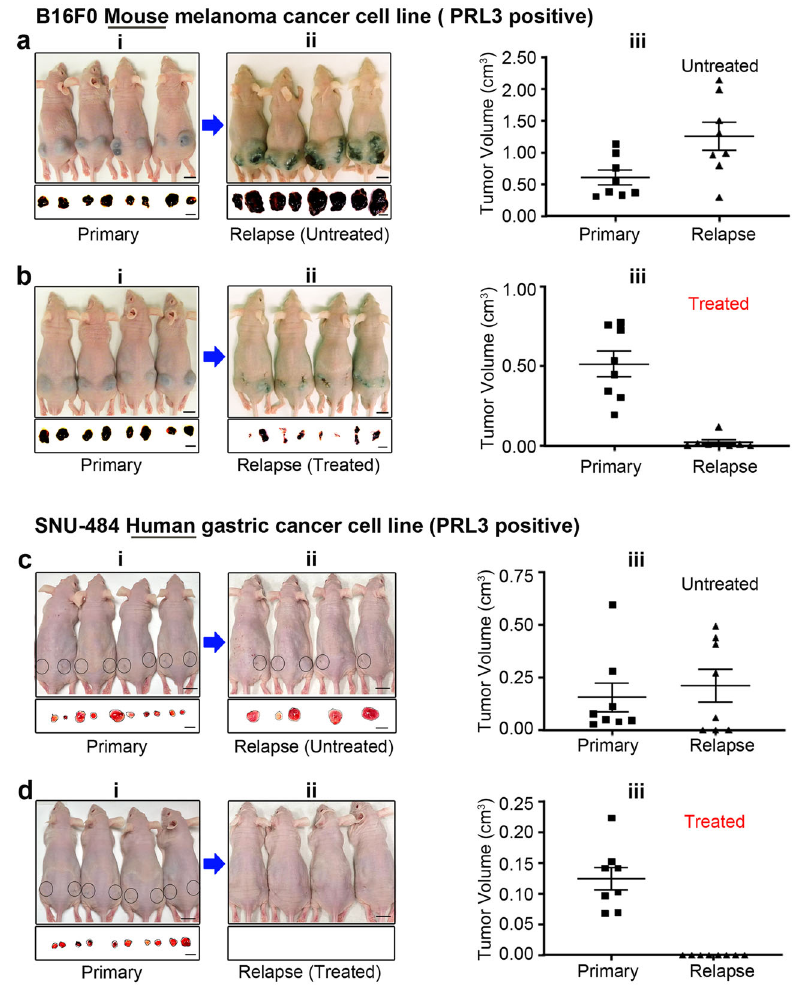
Fig. 4 PRL3-zumab, as an ‘ Adjuvant Immunotherapy ’ after tumor removal, prevent tumor relapse. a , b Mice with xenograft tumors formed by B16F0 (PRL3 positive) cells: 2 weeks after inoculation ( a – i , b – i upper panels) and removed primary tumors in black ( a – i , b – i , lower panels). Mice with relapse tumors formed 2 weeks after tumor removal in the untreated group ( a-ii ) and treated group ( b-ii ). Tumor volume of B16F0 primary ( a-i ) and relapse tumors ( a – ii ) from untreated group, n = 8, data represents mean ± SEM. P = 0.053 Student ’ s t -test ( a – iii ). Tumor volume of B16F0 primary ( b – i ) and fewer and smaller relapse tumors ( b – ii ) from treated group, n = 8, data represent mean ± SEM. P = 0.003 Student ’ s t -test ( b – iii ). c , d Mice with xenograft tumors formed by SNU-484 (PRL3 positive) cells: 2 weeks after inoculation ( c – i , d – i mice image at upper panel) and removed primary tumors ( c – i , d – i , tumor images at lower panel). 2 weeks after tumor removal from untreated group ( c – ii , mice image at the upper panel and removed tumor at the lower panel), and PRL3-zumab treated group ( d – ii , mice image at the upper panel and no tumor relapse at the lower panel. Tumor volume of SNU-484 primary ( c – i ) and relapse tumors ( c – ii ) from the untreated group, n = 8, data represent mean ± SEM. P = 0.45 Student ’ s t -test ( c – iii ). Tumor volume of SNU-484 primary ( d – i ) and no relapse tumors ( d – ii ) from treated group, n = 8, data represents mean ± SEM. P < 0.0002 Student ’ s t -test ( d – iii ). Black circle over the mouse indicates tumor location. Bar, 10